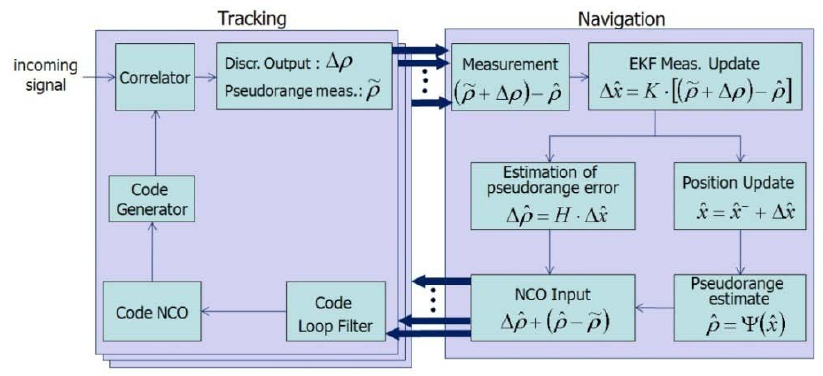
Figure 4. Construction of